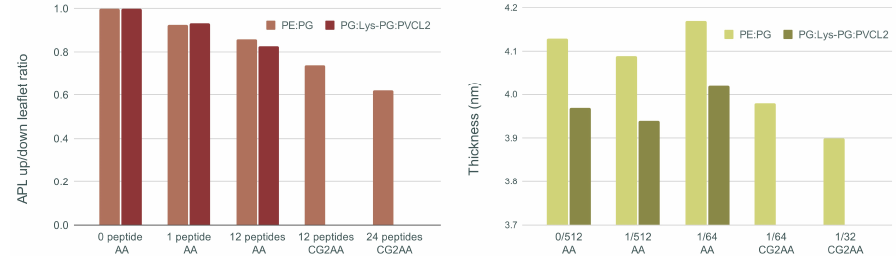
Figure 7. On the ( left ) ratio of upper and lower leaflet area per lipid (APL) averaged over the last 100 ns of simulation time, and on the ( right ) membrane thickness averaged over the last 100 ns of simulation time for each case of AA and CG2AA simulations. Calculations are done with the APL@voro tool